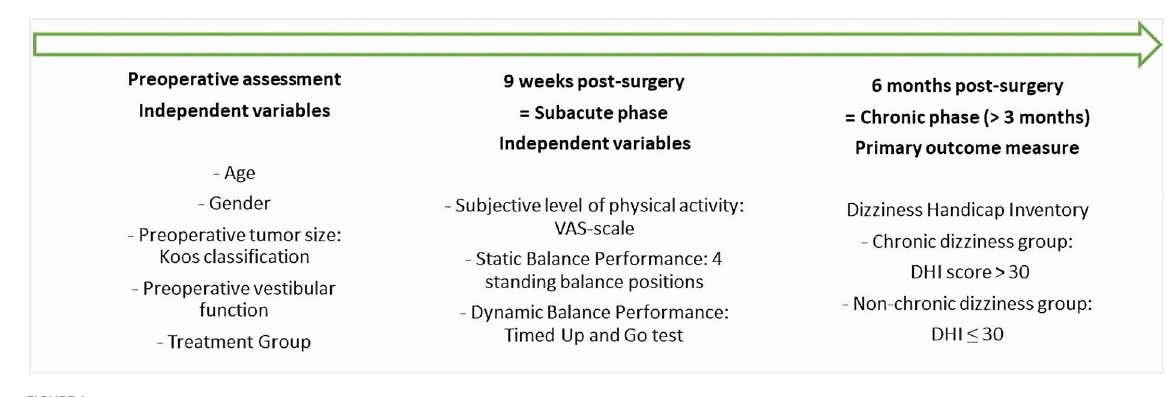
FIGURE1 Timeline clinical